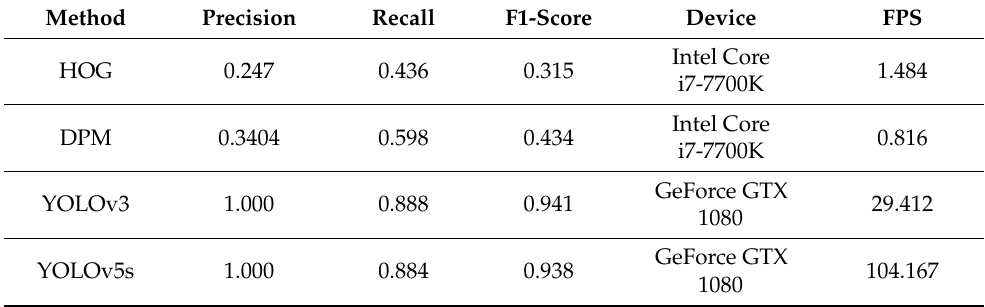
Table 6. The method comparison in terms of the detection accuracy and detection